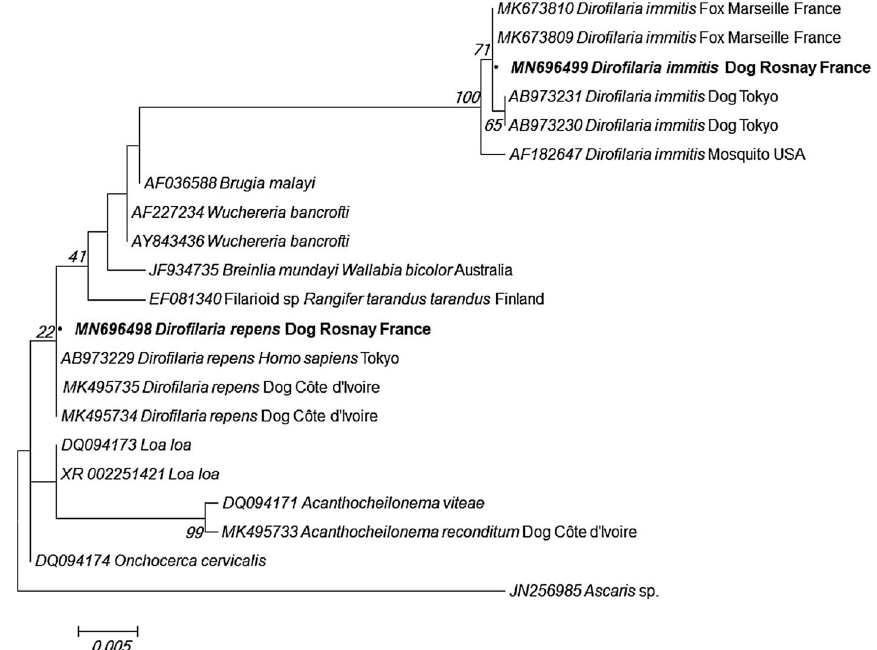
Figure 1. Molecular phylogenetic analysis of the 18S rRNA gene, using the maximum likelihood method based on the Kimura 3-substitution- type model.